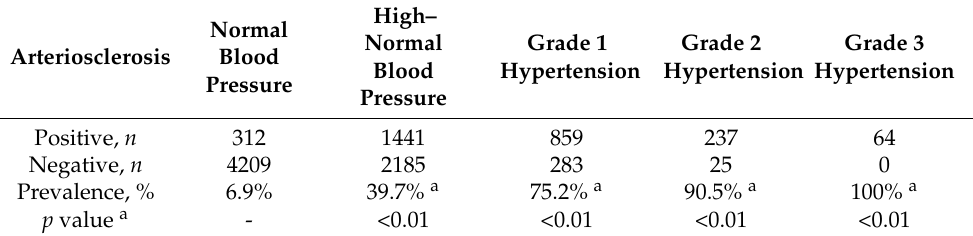
Table 2. Prevalence of arteriosclerosis in different blood pressure grades.